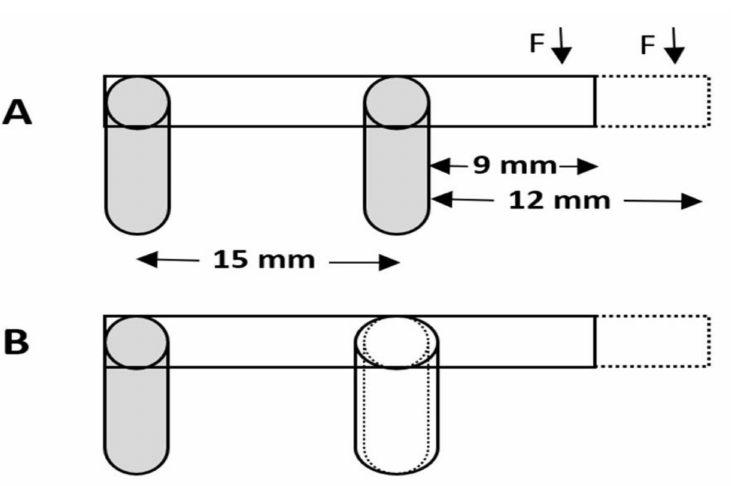
Figure 1. Schematic representation of ( A ): Cantilever frameworks on 2 implant analogs; ( B ): Can- tilever frameworks with reinforced distal